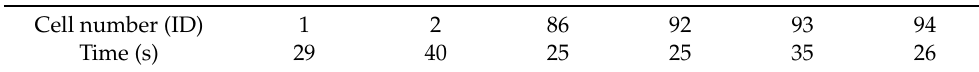
Table 5. The deviation of 12 mV from the average.